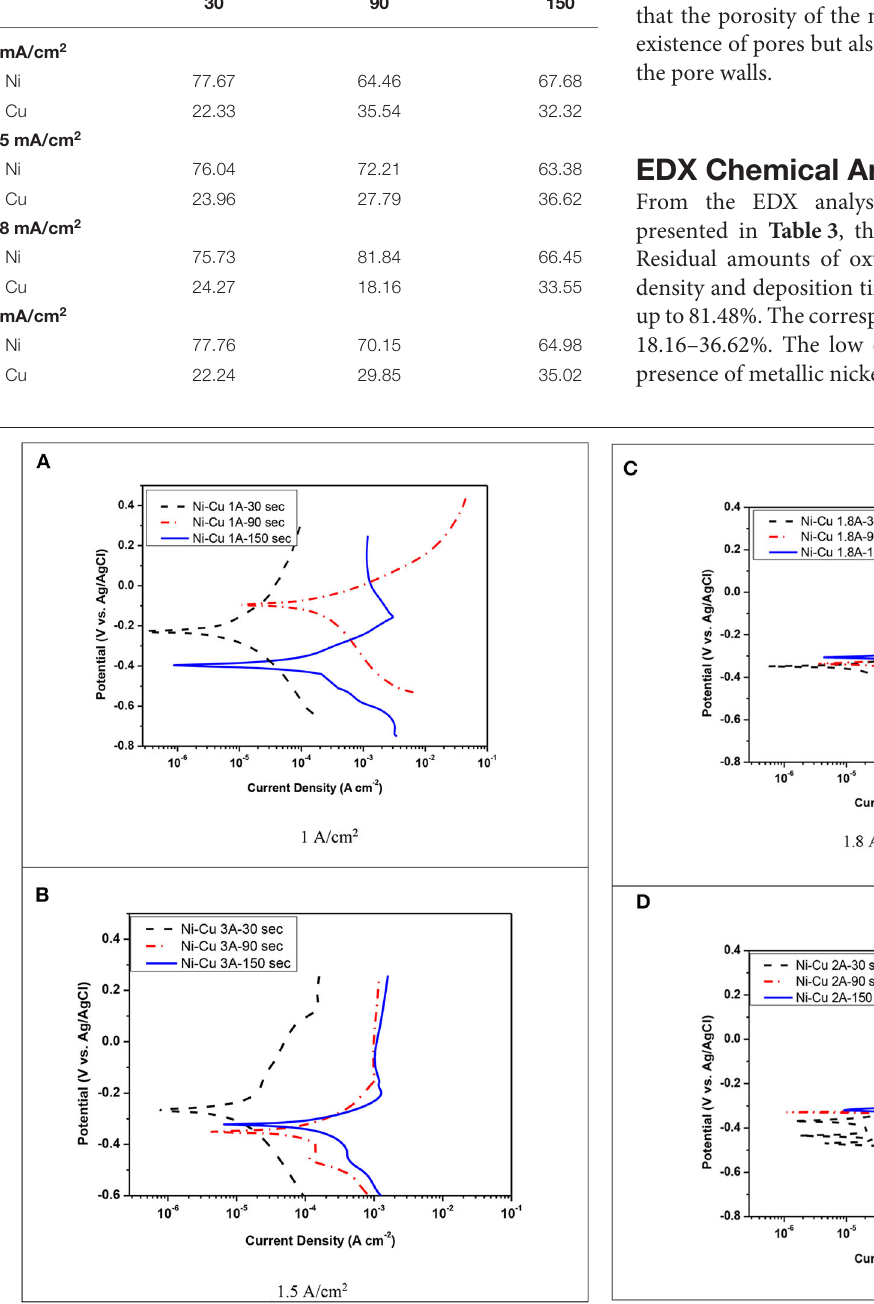
Frontiers in Mechanical Engineering |